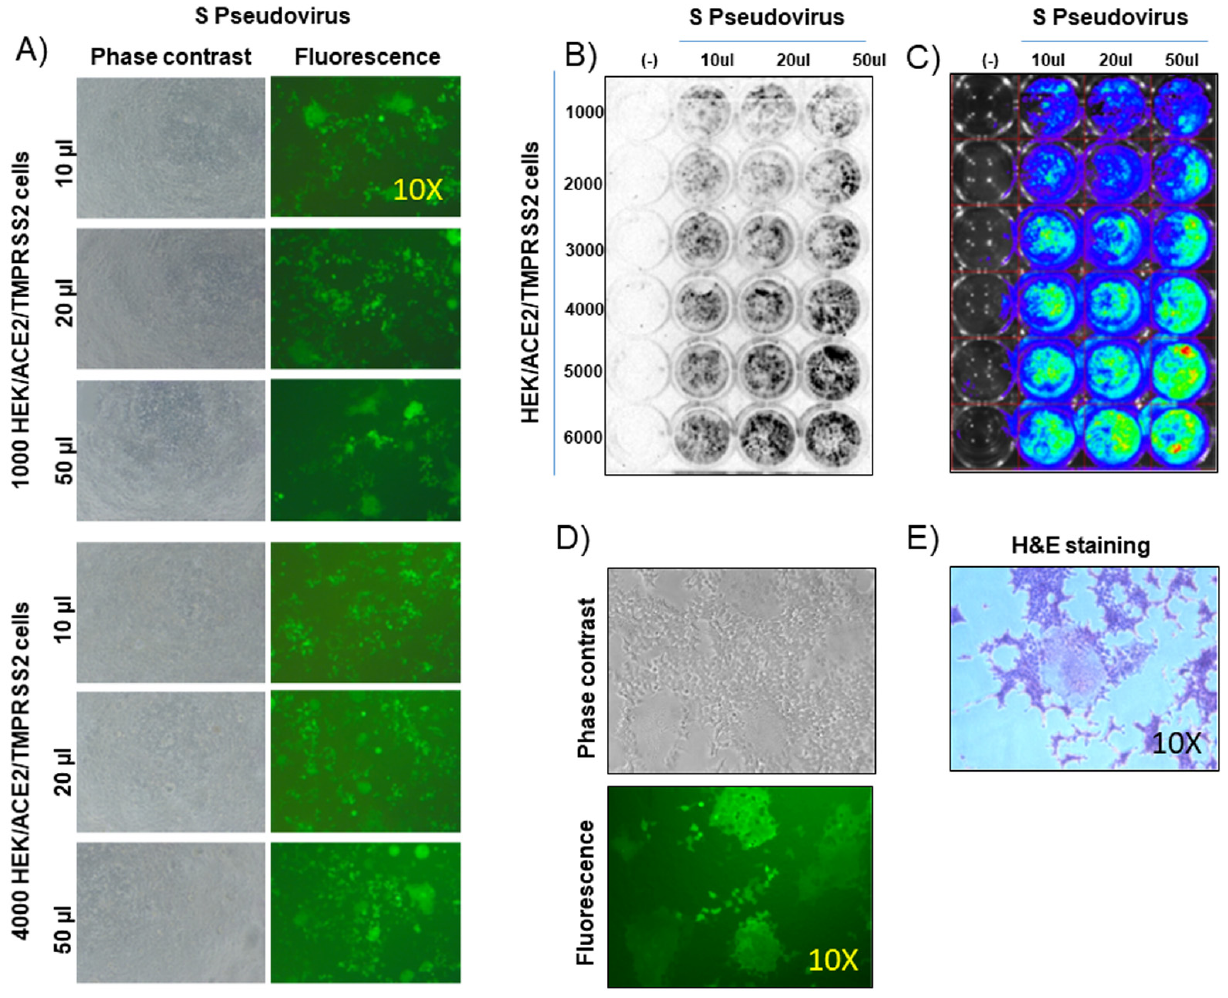
Figure 2. Pseudovirus assembly and transduction. ( A ) Representative images (phase contrast and fluorescence; 10X) of HEK/ACE2/TMPRRS2/Puro cells, at different numbers (1000 and 4000), transduced with different amounts (50, 20, and 10 μ L) of supernatant containing pseudovirus. ( B ) ChemiDoc and ( C ) IVIS luminometric detection of HEK/ACE2/TMPRRS2/Puro cells, at different numbers (1000, 2000, 3000, 4000, 5000, and 6000), transduced with different amounts (50, 20, and 10 μ L) of supernatant containing pseudovirus (S pseudovirus). Negative control was established with HEK293T cells, at different numbers (1000, 2000, 3000, 4000, 5000, and 6000) and transduced with 50 μ L of the same supernatant containing pseudovirus (S pseudovirus). ( D ) Representative images of syncytia (phase contrast and fluorescence of the same field; 10X), generated by pseudovirus-transduced HEK/ACE2/TMPRRS2/Puro cells. ( E ) Representative images of a syncytium (phase contrast; 10X) generated by pseudovirus-transduced HEK/ACE2/TMPRRS2/Puro cells and stained with hematoxylin and eosin (H&E staining).